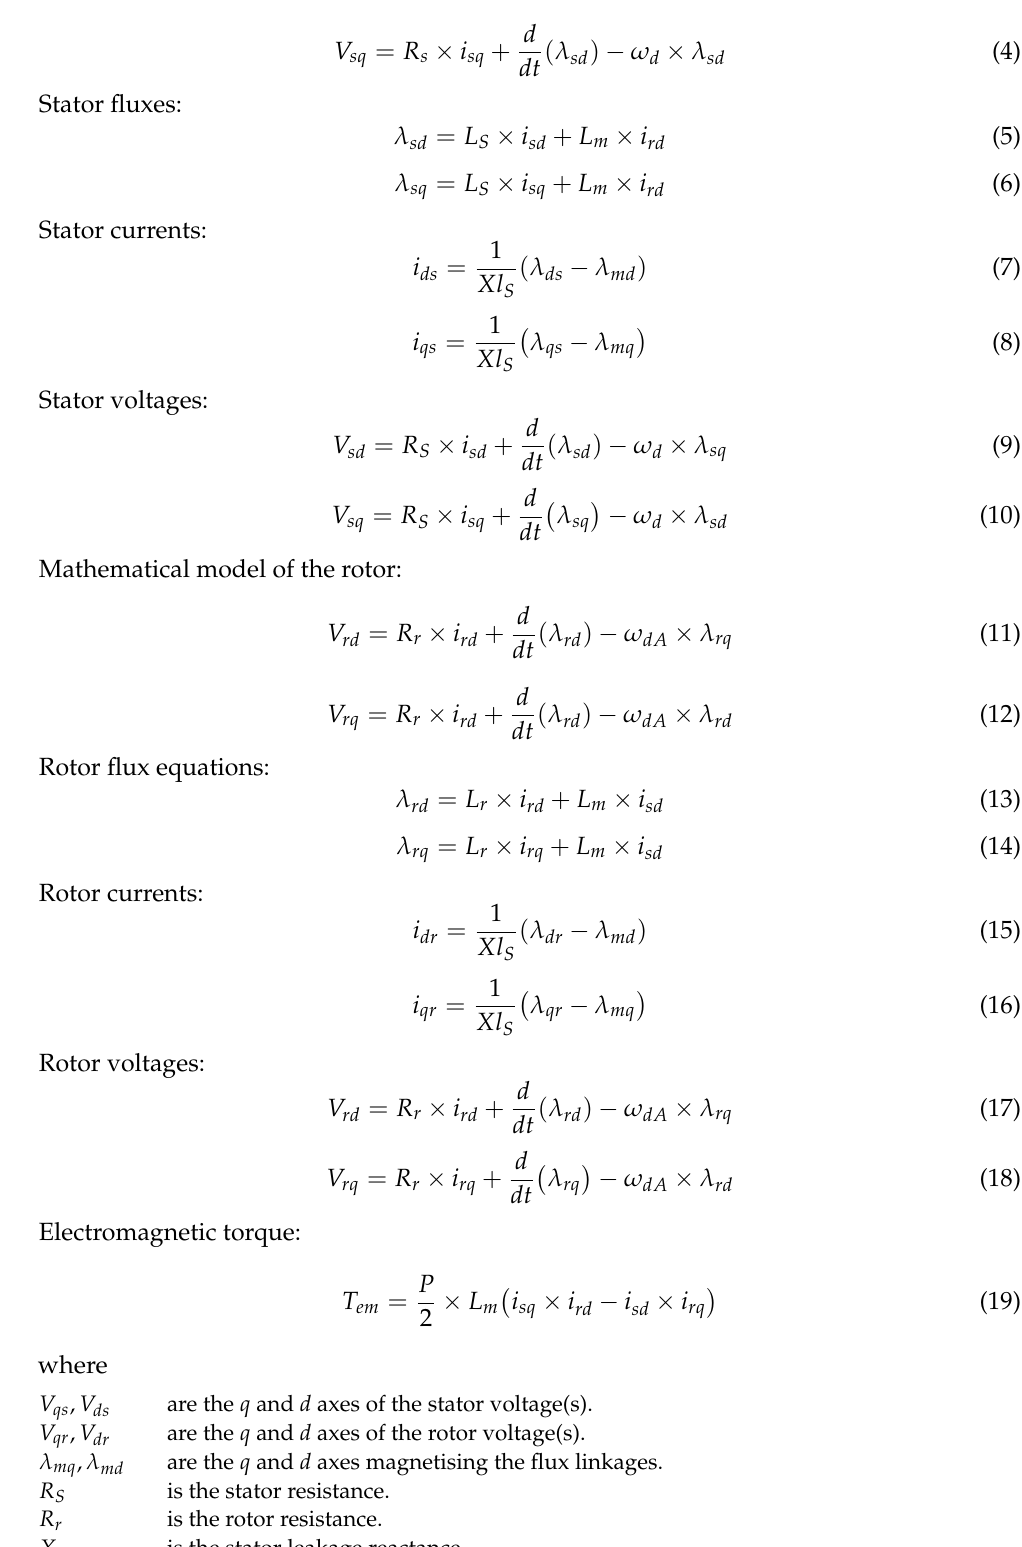
Figure 8a,b present the implantation of the dynamic model of the induction motor. The stator supply voltages and currents are presented in Figure 8a,b. The rotor